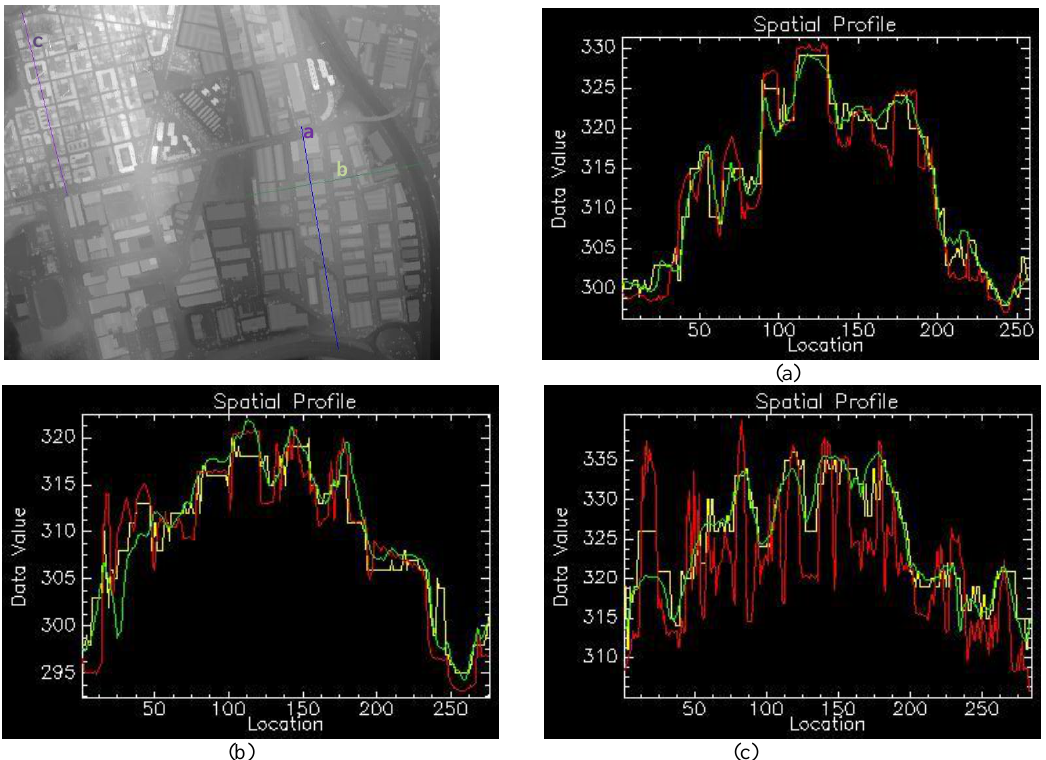
Figure 5. Height profiles of the original DSM (green), Lidar DSM (red) and enhanced DSM with planar fitting (yellow). On the left, the three profile segments are visualized on the Lidar